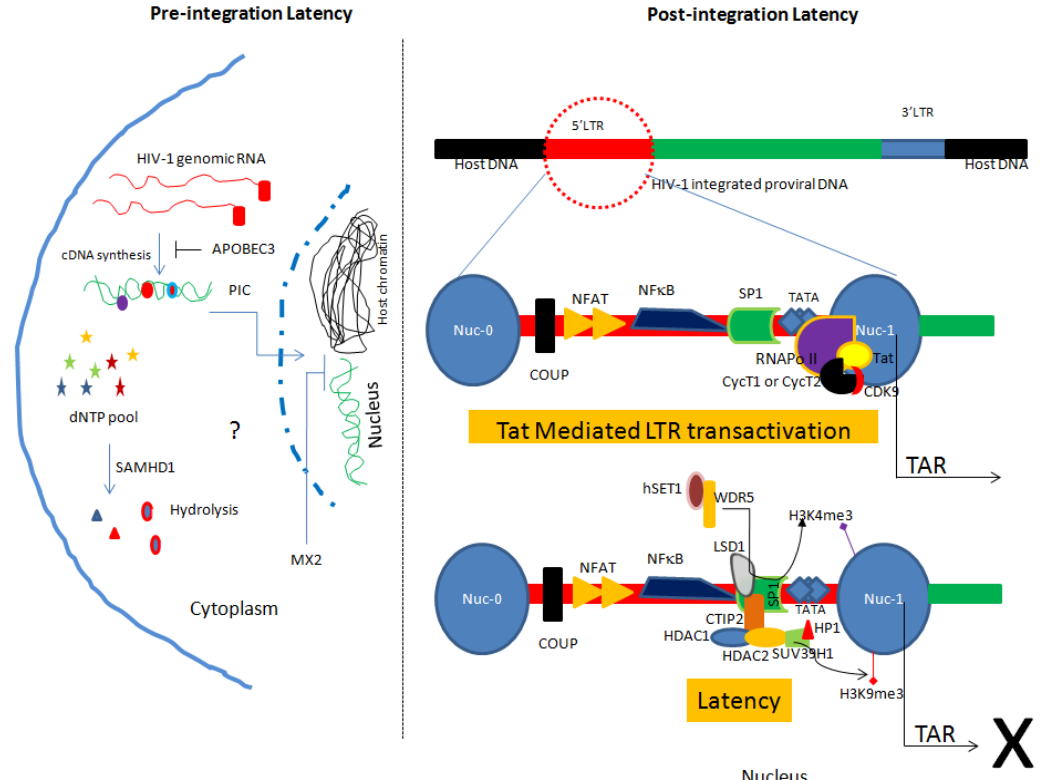
Figure 1. Model of pre-integration and post-integration latency in HIV-1 infected monocytes/macrophages. Pre-integration latency is governed by interplay of host restriction factors including APOBEC3, SAMHD1 and MX2. Such form of latency is more relevant in the cells of monocyte/macrophage lineage. On the other hand, post-integration latency is manifested by several mechanisms that include chromatin remodeling, epigenetic